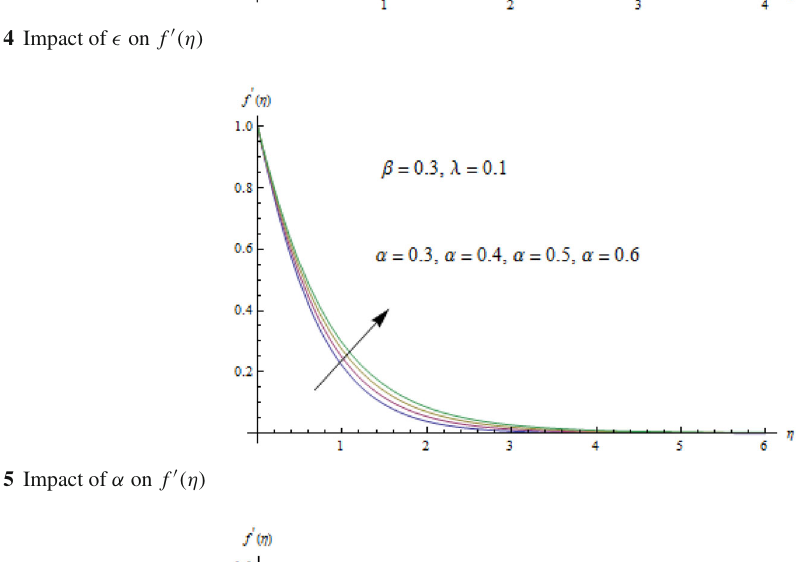
Fig. 4 Impact of (cid:2) on f (cid:5) (η)